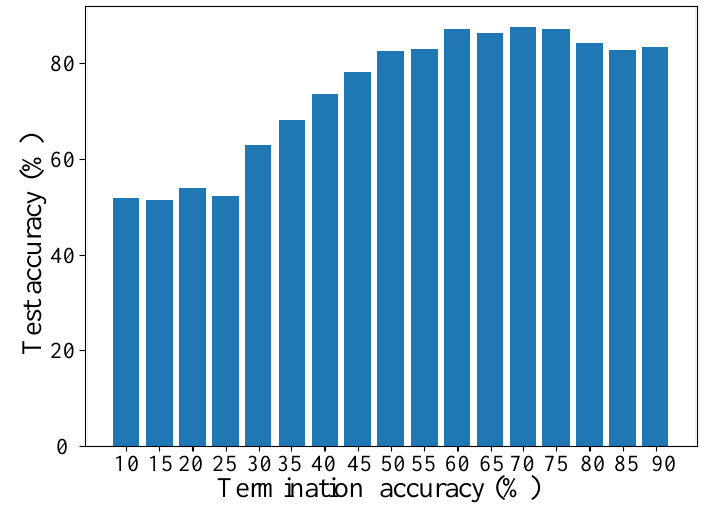
13 of 17 Table 2. Training and testing results for each model when using only 200 target domain samples. Methods